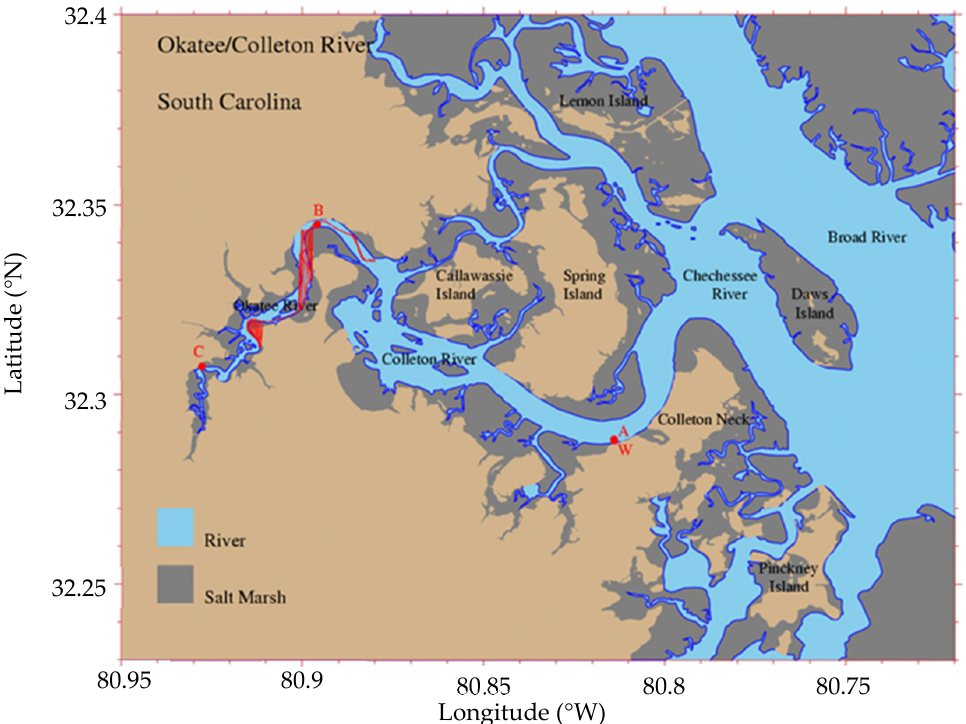
Figure 1. Geometric locations of the Okatee/Colleton River Estuary. Light gray: Inter-tidal saltmarsh areas and tan: lands. Labels A, B, and C are the three mooring sites where the sea levels and tidal currents were measured. The red lines: the vessel-towed ADCP survey tracks.